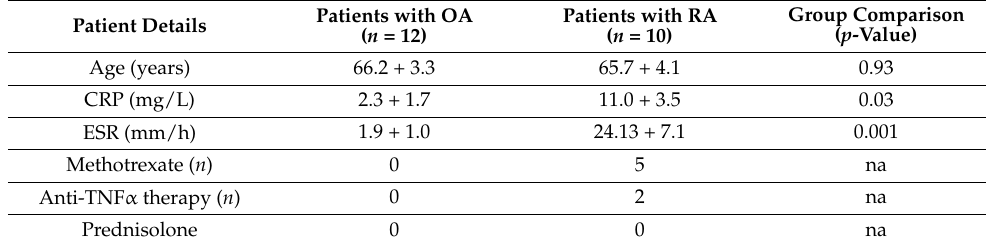
Table 1. Patients’ characteristics for human skeletal muscle biopsies. Biopsies were collected from pa- tients with either rheumatoid arthritis (RA) or osteoarthritis (OA) following elective joint replacement surgery. Patient age, C-reactive protein (CRP), erythrocyte sedimentation rate (ESR) and concurrent therapeutic interventions were recorded prior to